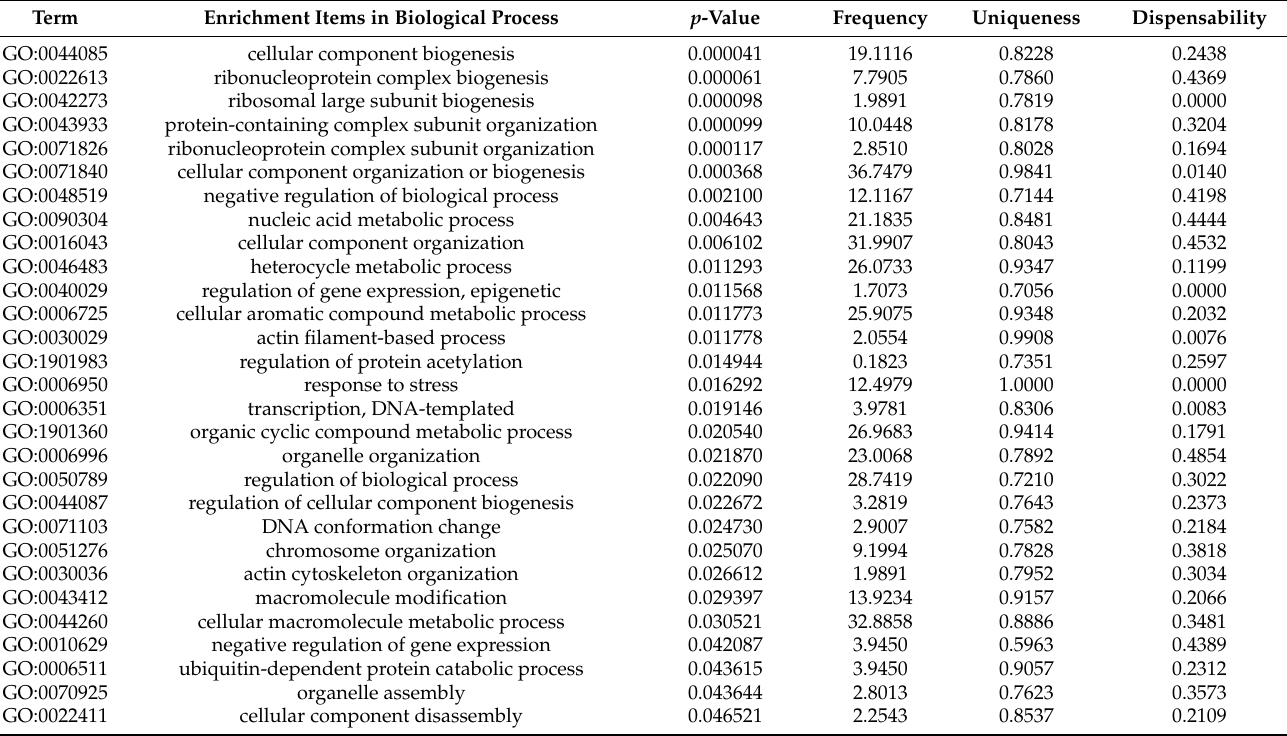
Table 2. Non-redundant enrich items in the biological process of gene ontology provided by RE- VIGO